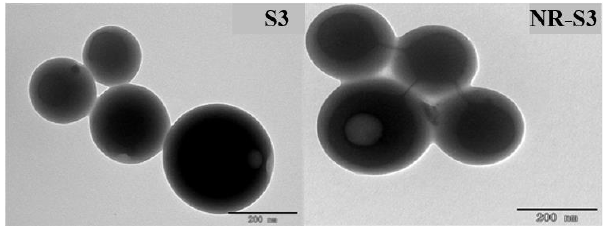
Figure 8. TEM images of Nile red-unloaded (S3) and Nile red-loaded (NR-S3) micelles (scale bar: 200 nm).